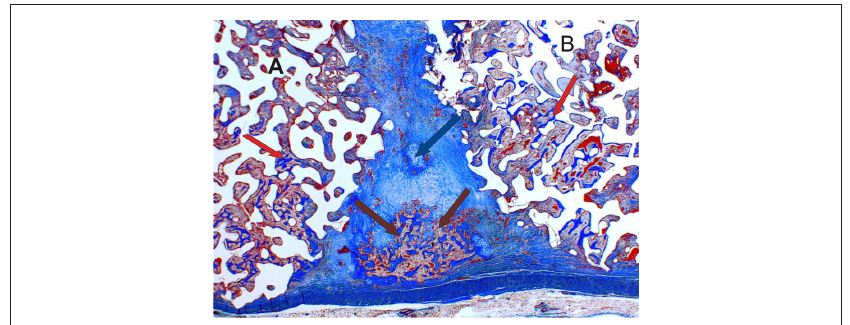
Figure 1 | in chaos there is order. Two calcium phosphate macroporous devices A and B, loaded with two bone inducing morphogens each, implanted into heterotopic sites of non-human primate Chlorocebus pygerythrus. Both of the devices are in close proximity to each other. Bone formation (red arrows) occurs within each device, together with some cartilage formation (blue arrow) and bone marrow development (brown arrows) , in a potential tractional field between the two implanted macroporous devices (magnification 2 ×